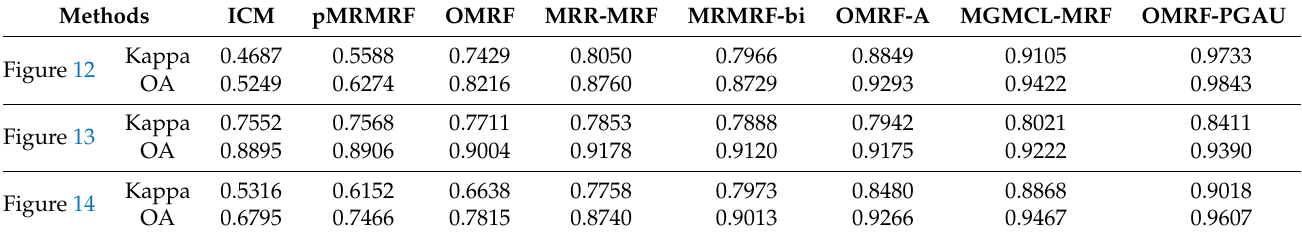
Table 3. Quantitative indicators of eight comparison methods for three Gaofen-2 images.